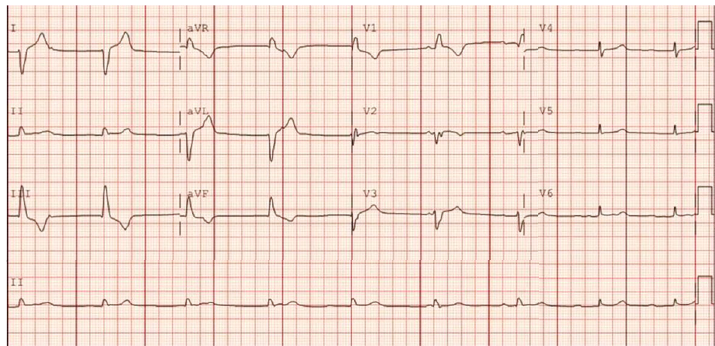
Figure 8: EKG showing third degree complete AV